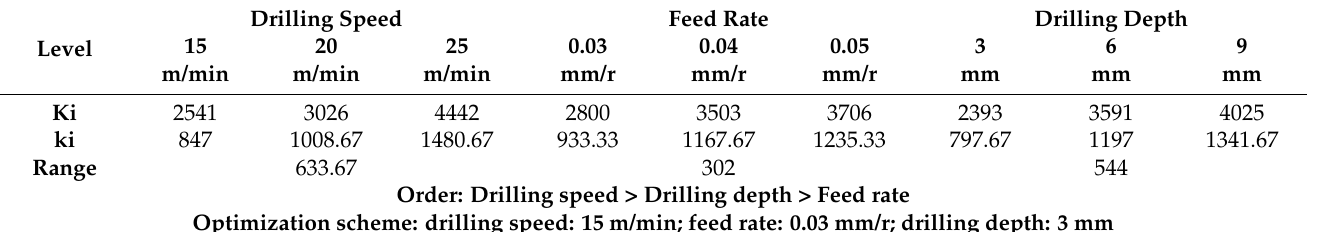
Table 9. Range analysis of drilling force.